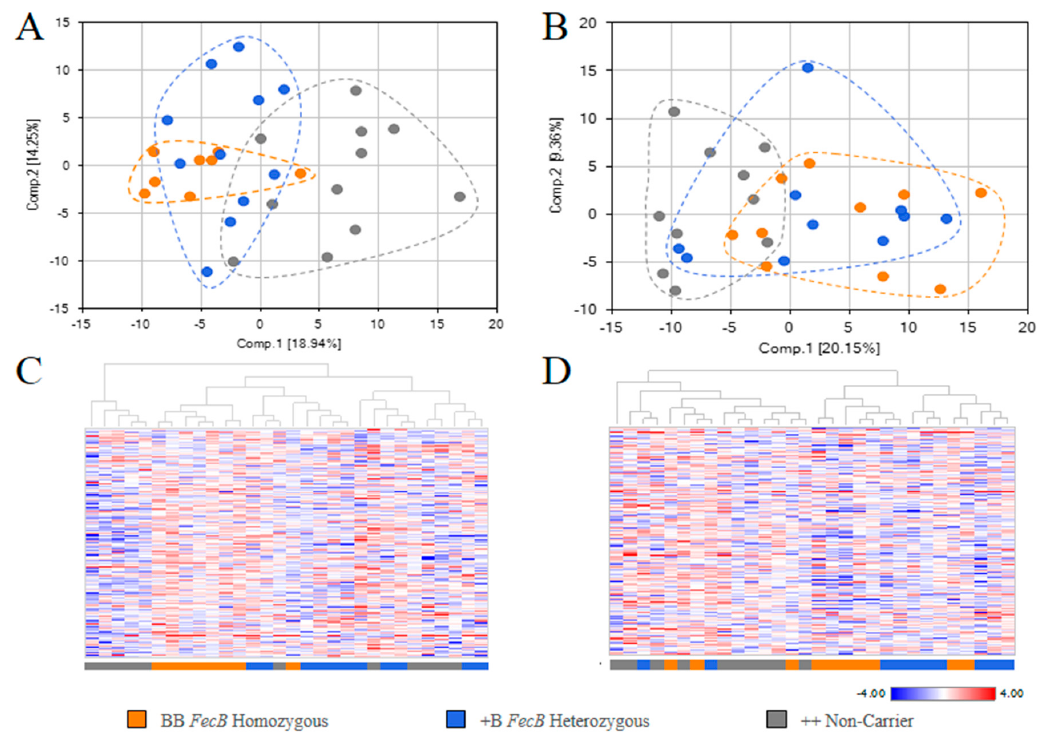
Figure 2. Samples clustering analysis using PCA and HCA: ( A ) PCA analysis of FF samples; ( B ) PCA analysis of OVS samples; ( C ) HCA analysis of FF samples; ( D ) HCA analysis of OVS samples.